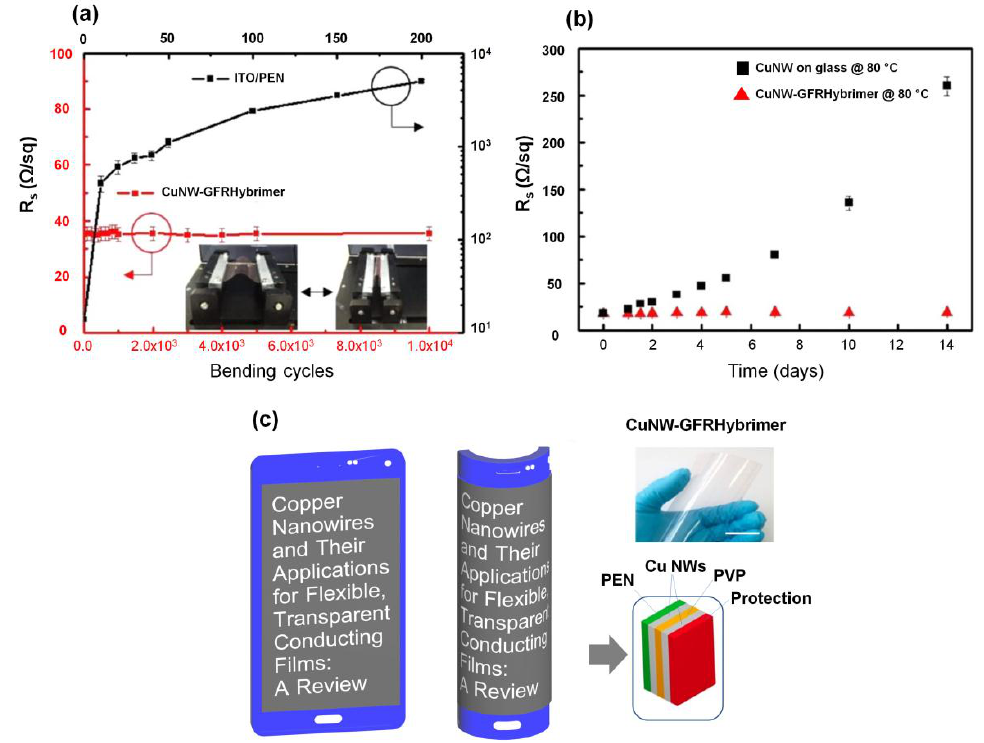
Figure 7. ( a ) Bending test results of a GFRHybrimer film (sheet resistance, R s = 35 Ω/sq) and a reference indium tin oxide (ITO)/polyethylene naphthalate (PEN) film ( R s = 15 Ω/sq). Top and right axes are for the ITO/PEN (the inset represents the experimental setup for the bending test; bending radius is 5 mm); ( b ) Thermal and oxidation stability tests of bare Cu NW film and CuNW-GFRHybrimer film at 80 °C; ( c ) A schematic example of flexible smartphone using Cu NWs in the future. The inset is a photograph of a Cu NW-GFRHybrimer film (scale bar is 3 cm). (Reproduced with permission from [88]. Copyright American Chemical Society, 2014).